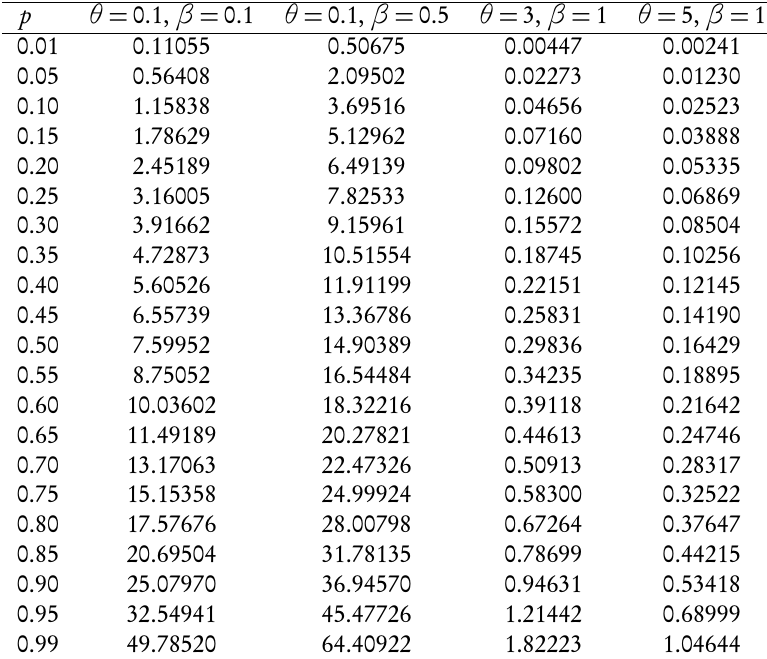
Quantiles of the GaL